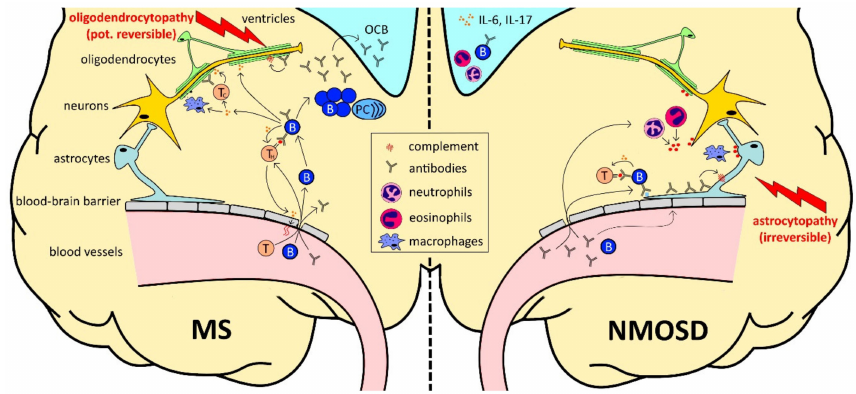
Figure 1. The role of B cells (B) in multiple sclerosis (MS) and neuromyelitis optica spectrum disorders (NMOSD). B cell development begins in the bone marrow. Transitional B cells enter the circulation and mature into naïve B cells after final maturation and selection in the spleen. In secondary lymphoid organs, upon antigen recognition, they di ff erentiate into plasma cells (PC) or memory B cells with the help of T cells (T). (1) In MS (infiltration-driven; left side), B cells themselves cross the disrupted blood–brain barrier and form plasma cell clones within the brain parenchyma and meningeal tertial B cell follicles, which resemble the local source of oligoclonal bands (OCB), contributing to inflammation and destruction of the myelin sheet in the central nervous system. Infiltrating B cells also serve as highly e ff ective antigen-presenting cells, leading to optimal antigen-specific T cell, cytokine production and further disruption of the blood–brain barrier. (2) In NMOSD (antibody-driven; right side), peripheral plasma cells are the main source of high amounts of aquaporin 4-specific antibodies, targeting astrocytic end feet after crossing the disrupted blood–brain barrier, followed by an activation of the complement cascade. As a consequence of astrocyte destruction, cortical demyelination occurs at late stages of the disease. Interleukin-6 (IL-6), which was found to be increased in NMOSD, promotes the generation of T helper 17 cell lineage, secreting interleukin-17